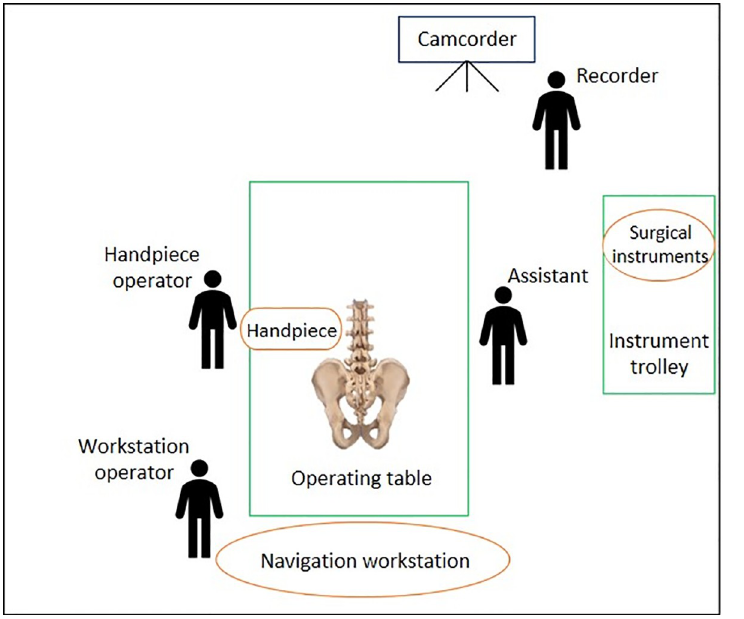
Fig 3. Experimental setup with a porcine spine.